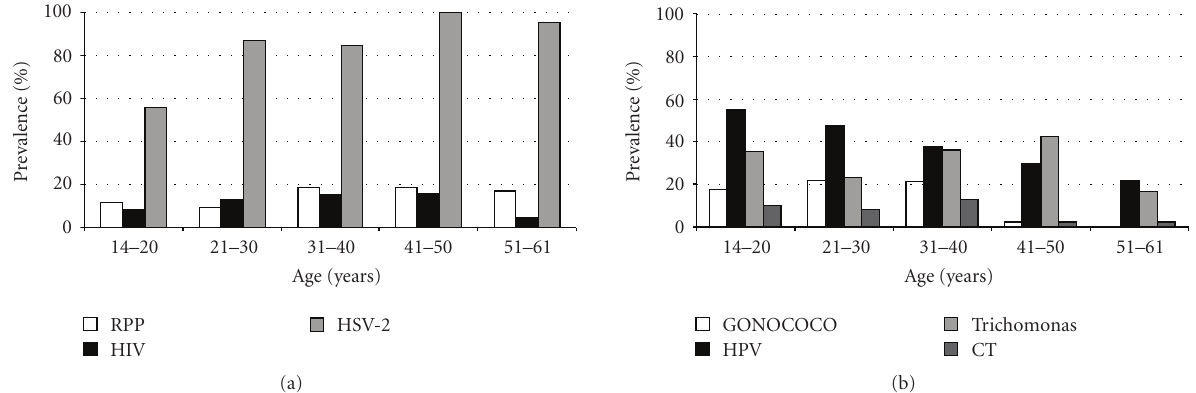
Figure 1: Seroprevalence of syphilis, HIV and HSV-2 (a) and prevalence of gonococcal, HPV, trichomonal and chlamydia trachomatis (CT) infections